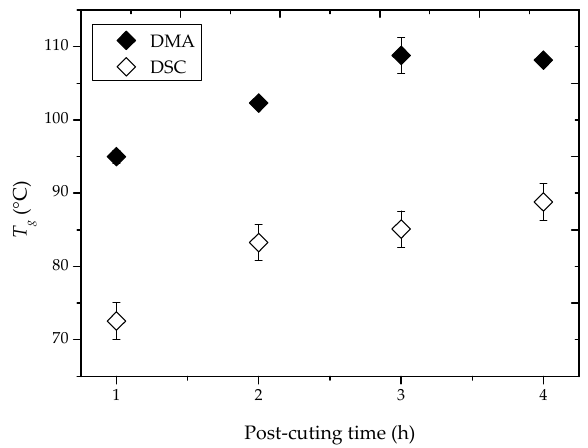
Figure 2. The effect of post-curing time on the glass transition temperatures deduced from both differential scanning calorimetry (DSC) and dynamic mechanical analyzer (DMA) measurements for 50 AM and a post-curing temperature of 130 °C.